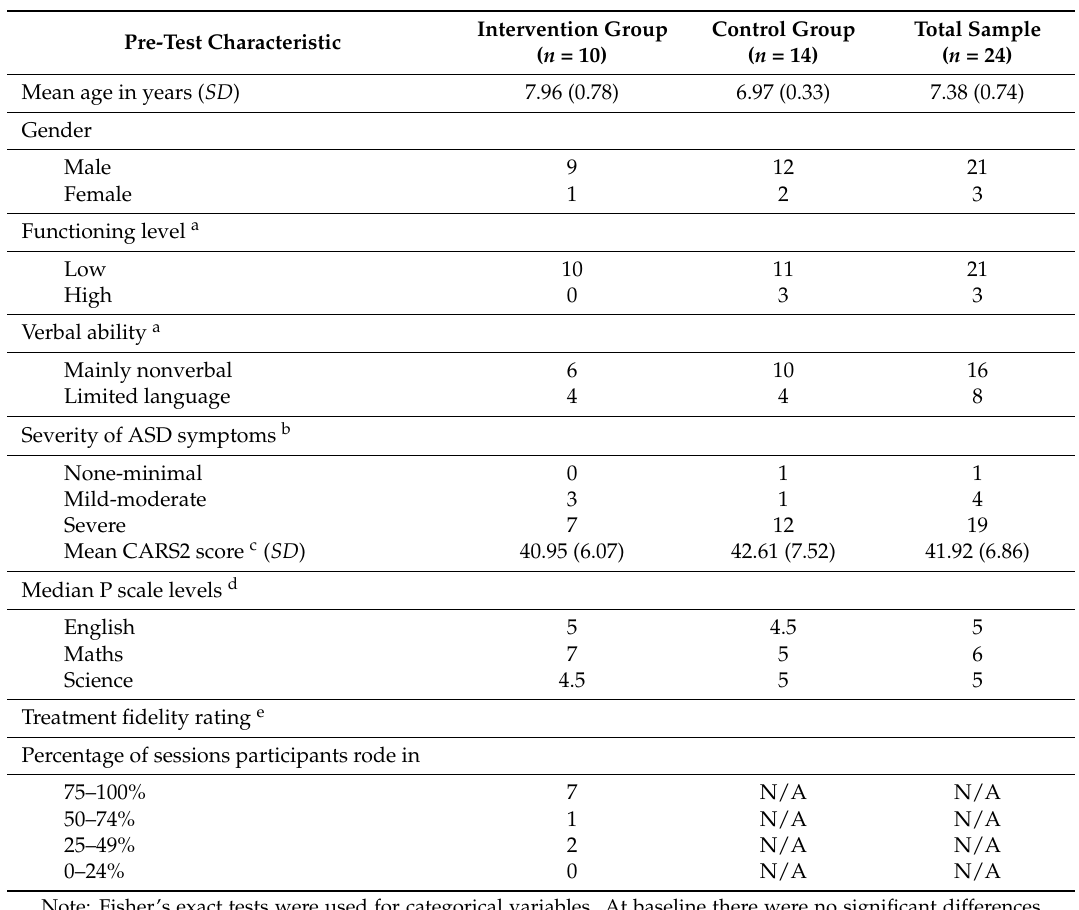
Table 1. Characteristics of Participants Who Completed the